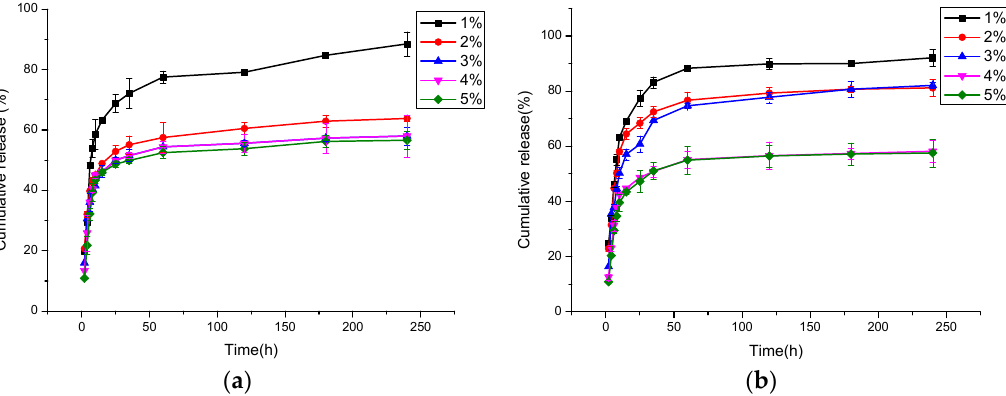
Figure 5. Cumulative release of Cur from porous and nonporous PLA/PEG/Cur CNFs with the different Cur contents: ( a ) Nonporous CNFs; ( b ) Porous CNFs.